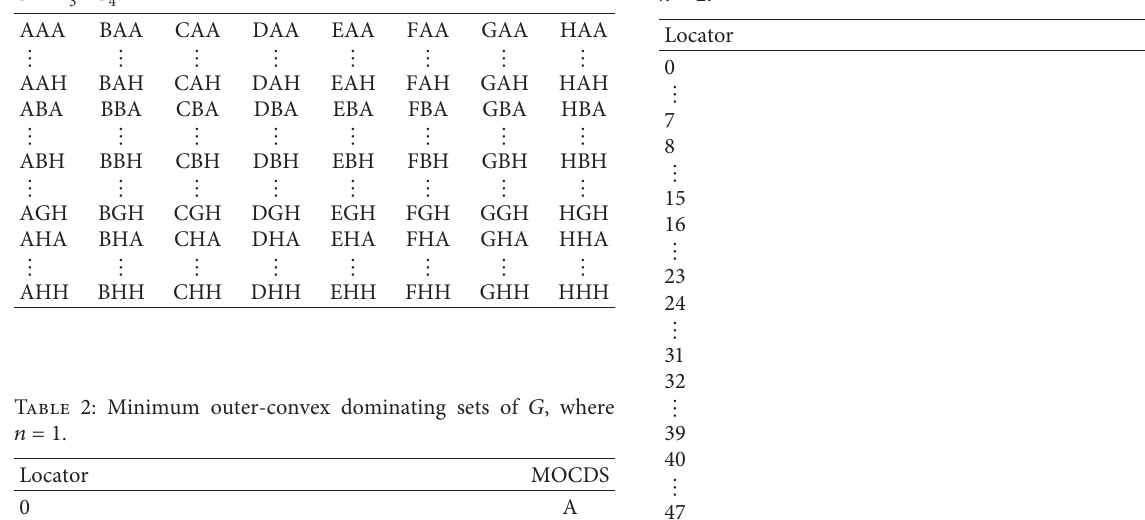
Table 1: Minimum outer-convex dominating sets of a graph G � P